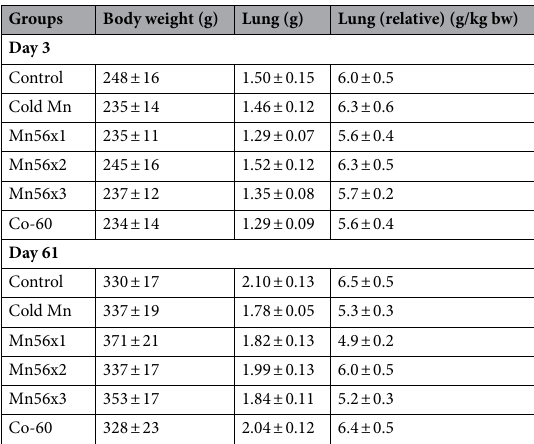
Table 1. Body and lung weights in rats exposed to 56 MnO 2 , 60 Co γ-rays, and cold MnO 2 . Each value shows mean ± SEM (n = 6 or 7, each